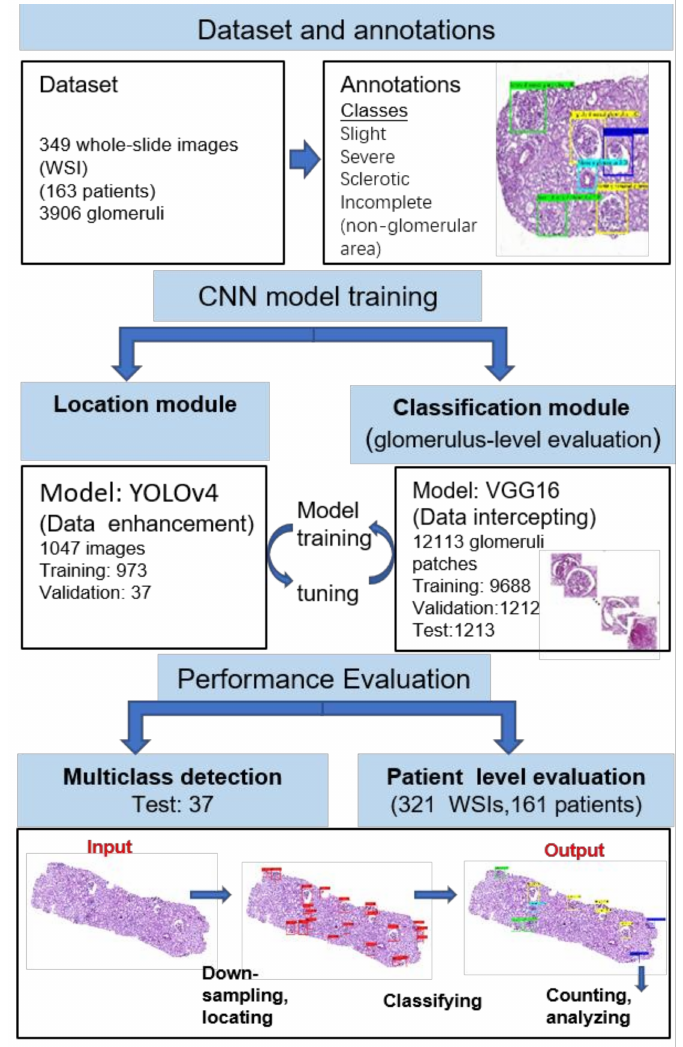
Figure 1. Overview of the experimental design. Given an input image, the glomeruli are located by using the localisation module, with subsequent analysis using the classification module that identifies the lesion class of each